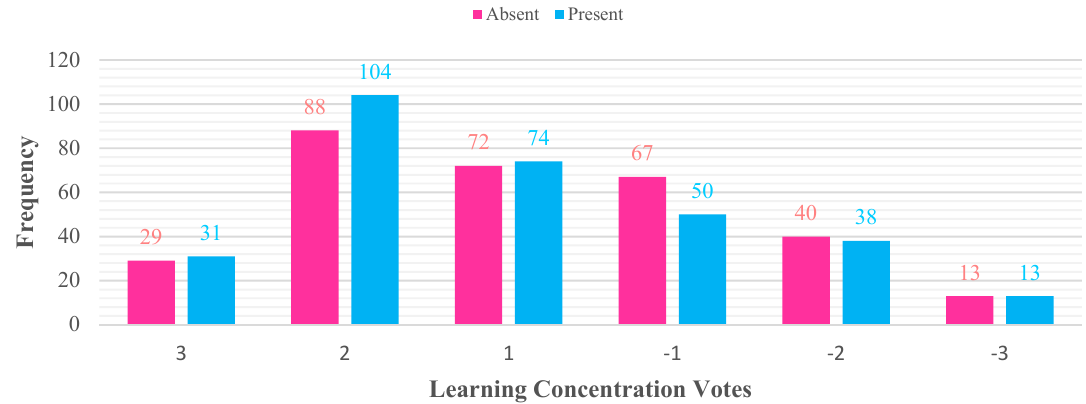
Figure 14. The distribution of learning concentrations according to plant